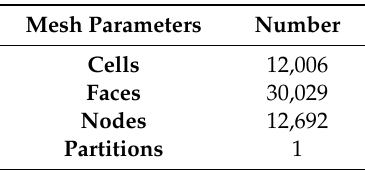
Table 3. Mesh parameters.